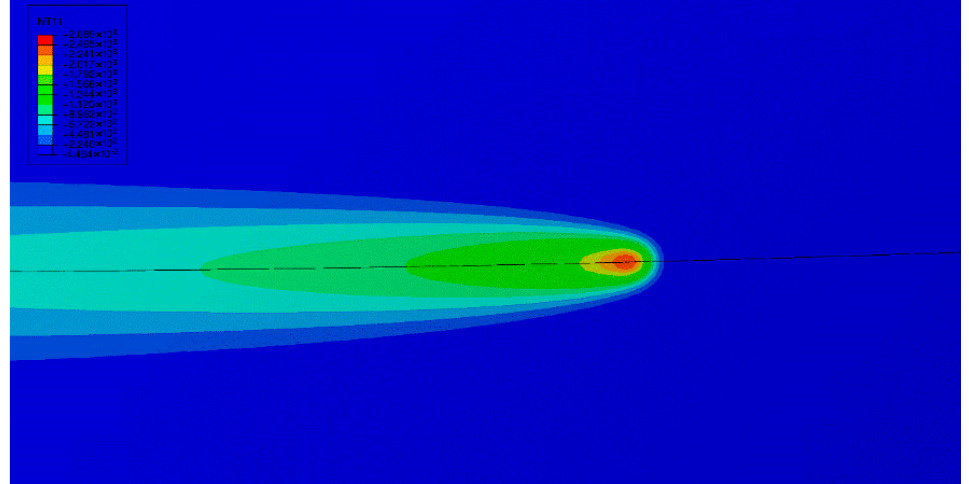
Figure 16. Enlarged temperature field of the spherical pressure hull when t = 12 s.